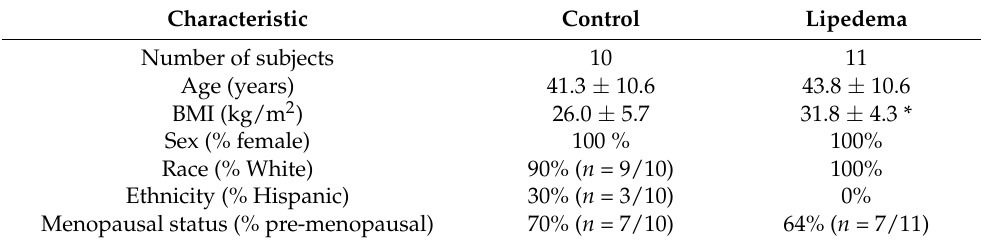
Table 3. Demographics for cohorts of human tissue